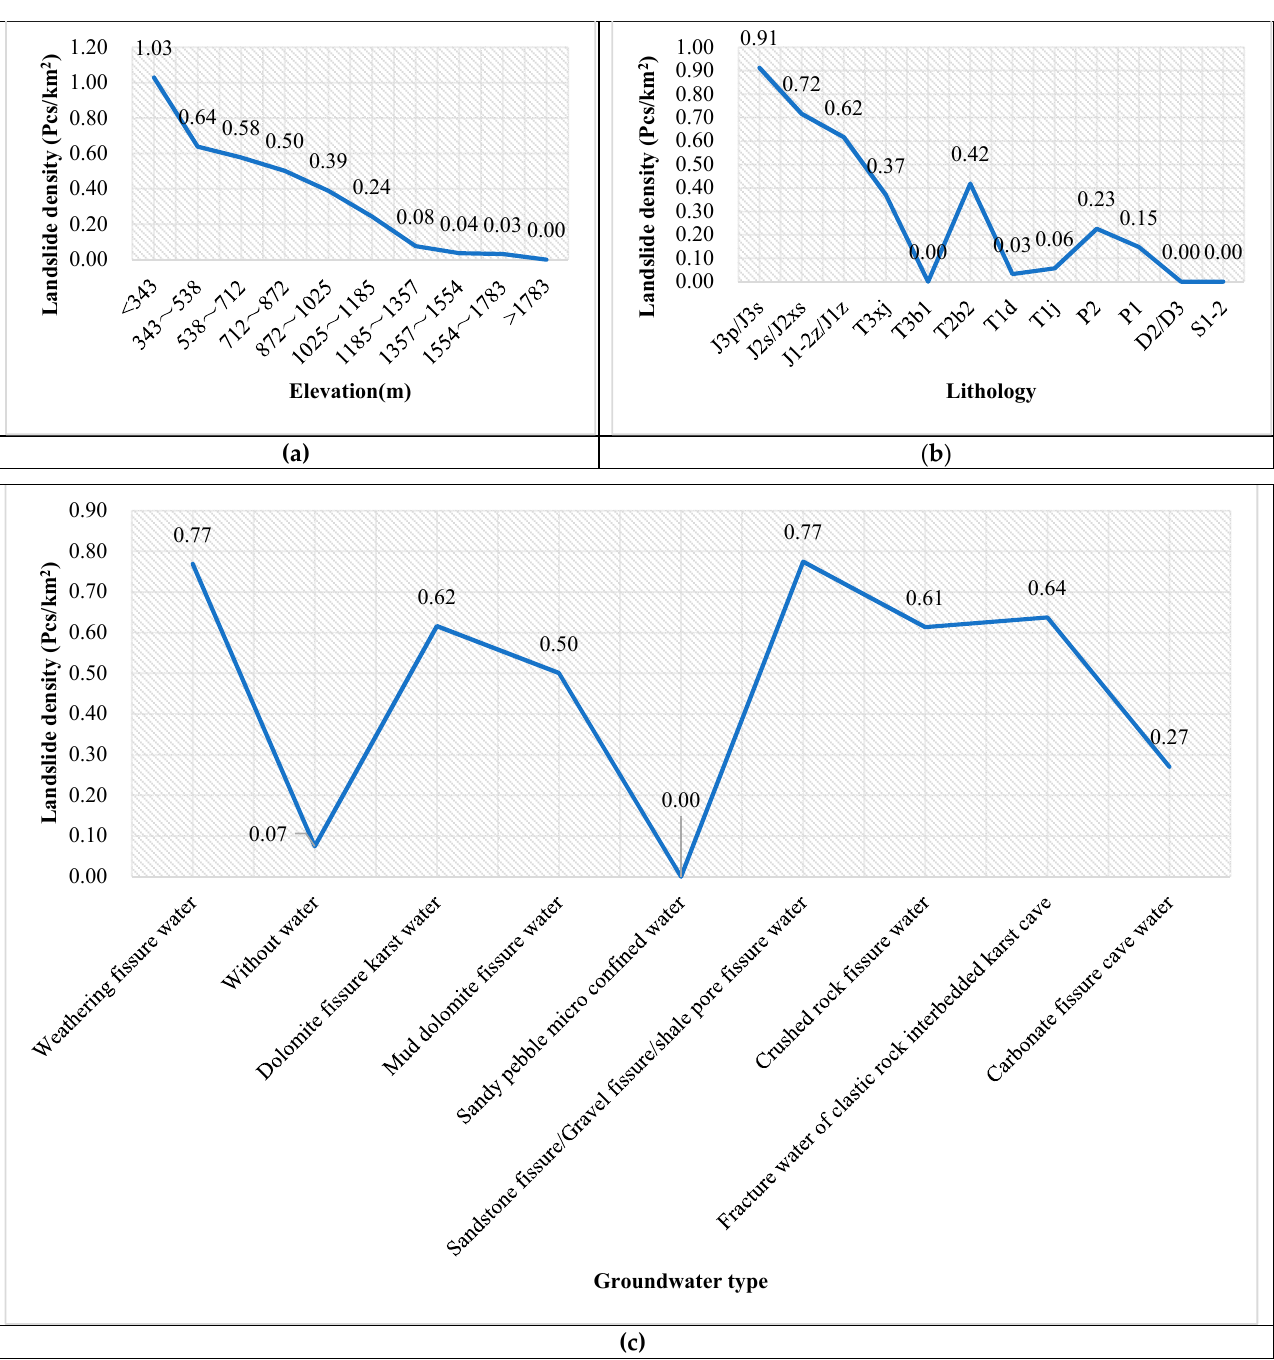
Figure 16. Typical factors in landslide density statistics: ( a ) Elevation; ( b ) Lithology; ( c ) Groundwater type.